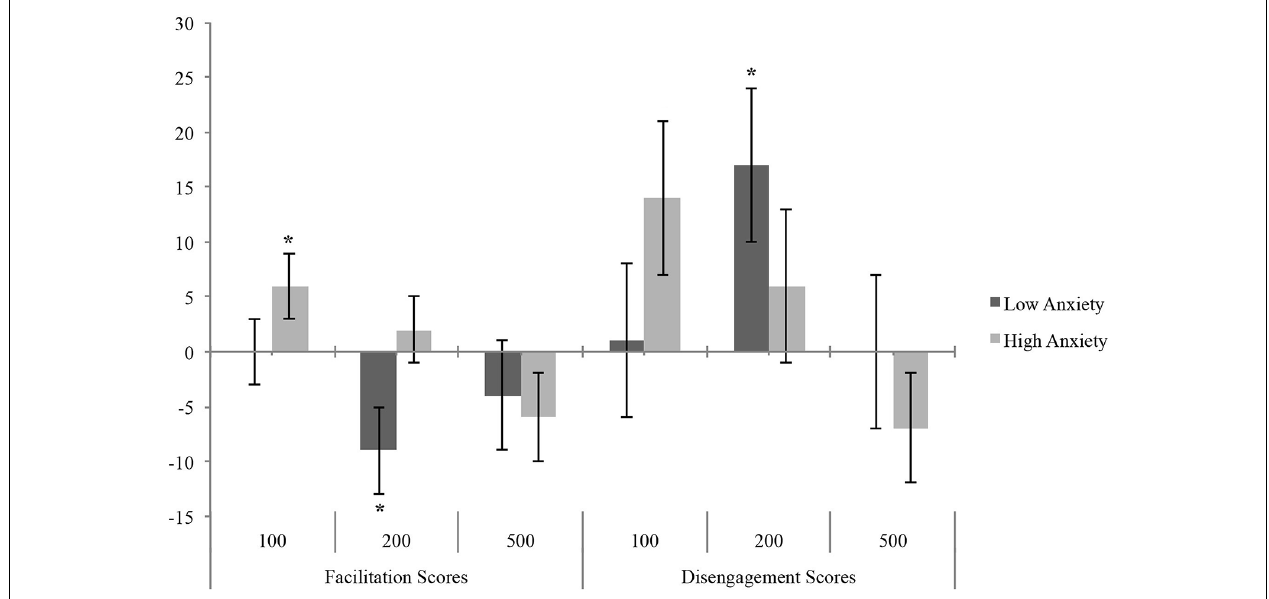
FIGURE 2 | Mean (and standard error) of Bias Score as a function of anxiety in LTA and HTA groups. Asterisks indicate significant differences between ABT and zero (* p < 0.05).